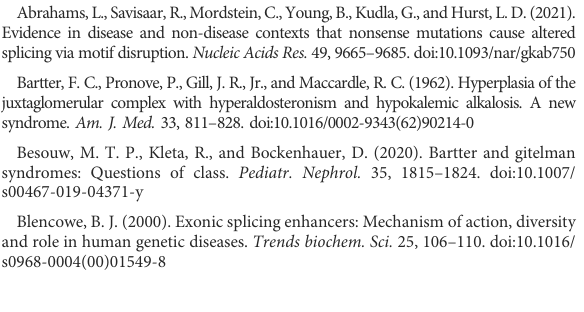
SUPPLEMENTARY FIGURE S1 The direct sequencing results of point variants in SLC12A1 and CLCNKB , the wild-type sequence is also